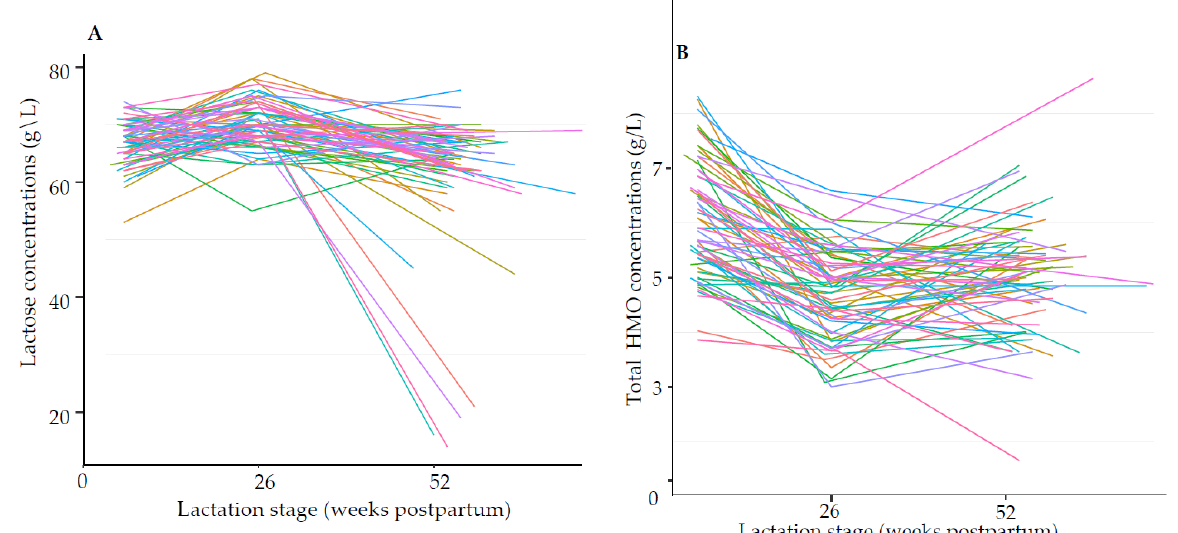
Figure 3. Multiple line plot of absolute ( A ) lactose and ( B ) total human milk oligosaccharide (HMO) concentrations (g/L) during lactation. Each line represents 1 sample among the lactating mothers with human milk samples collected at all three time points, 6 weeks, 6 months, and 12 months ( n = 66). Lactation stage was determined by the real age of the infant at the stage of lactation at which their respective mothers provided a human milk sample.